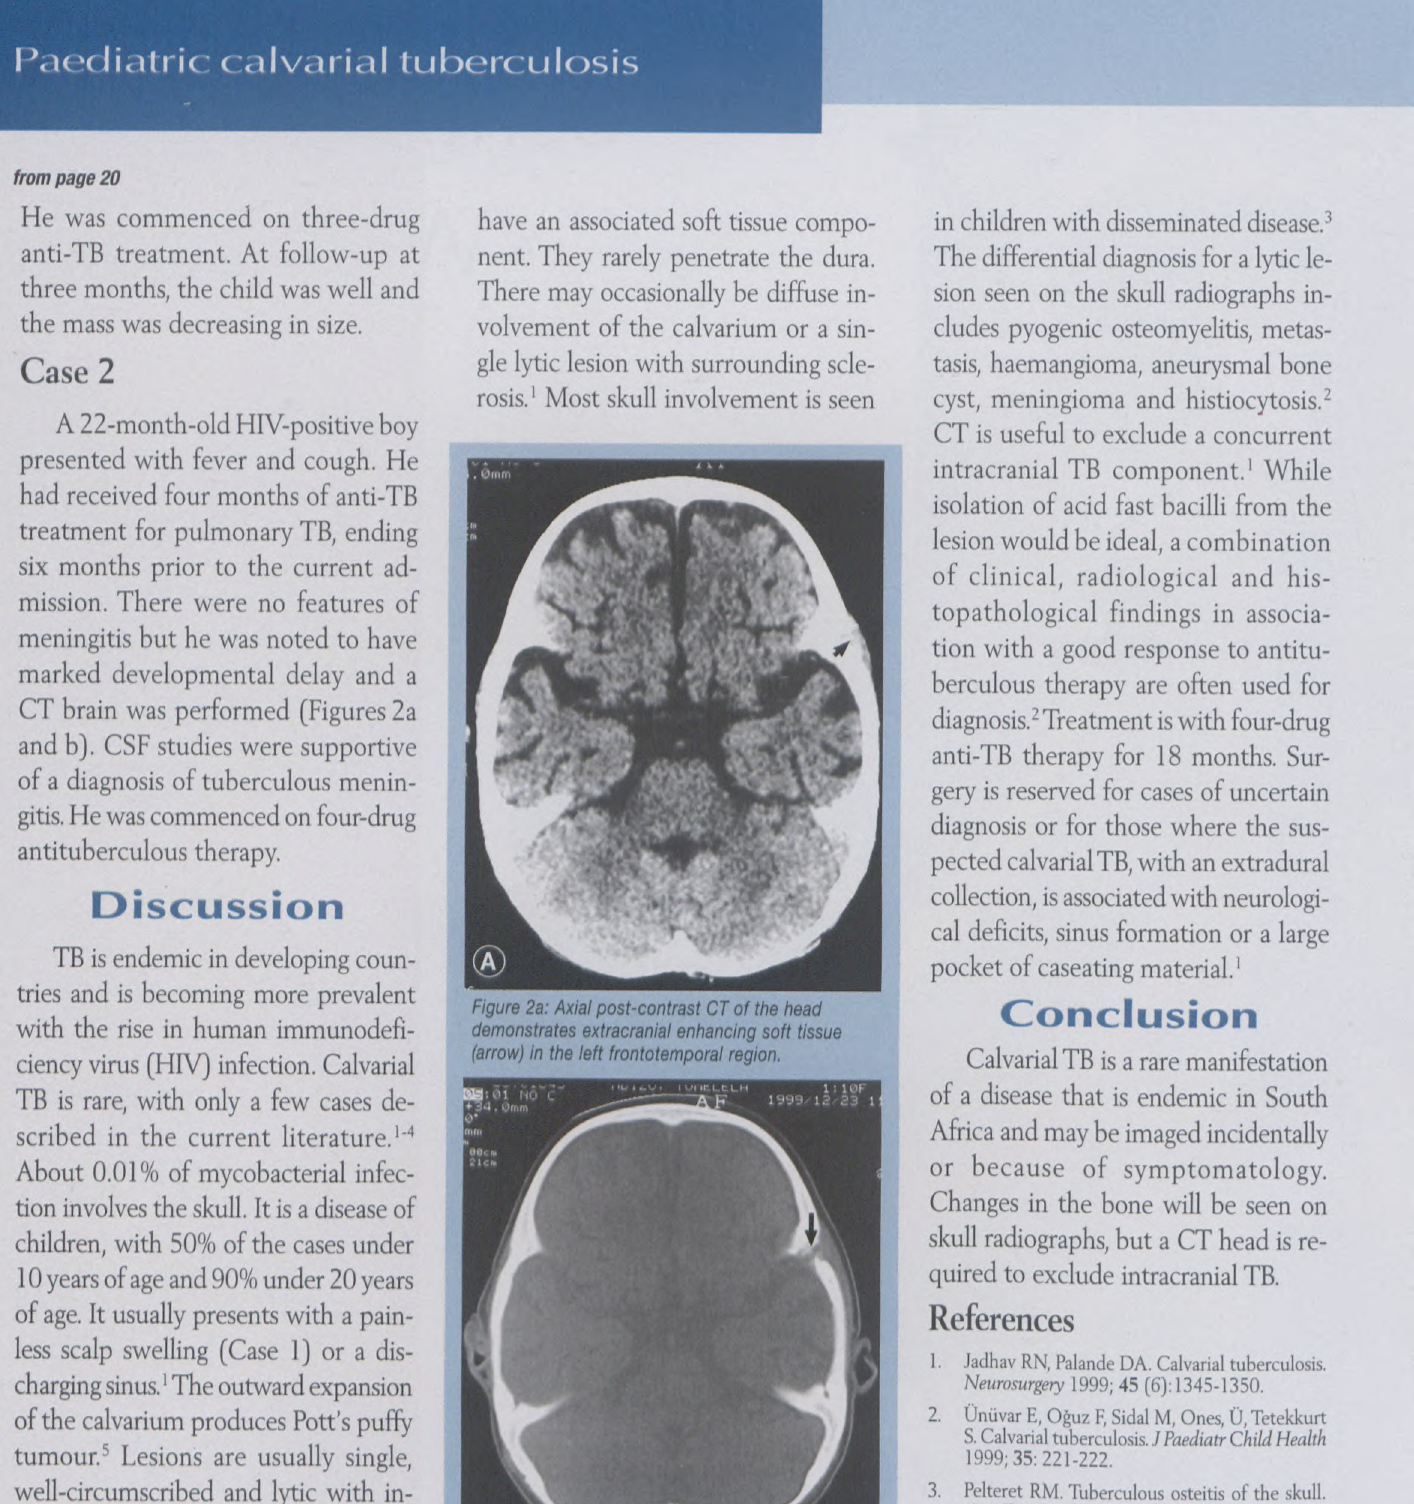
Figure 2a: Axial post-contrast CT of the head demonstrates extracranial enhancing soft tissue (arrow) in the left frontotemporal region.